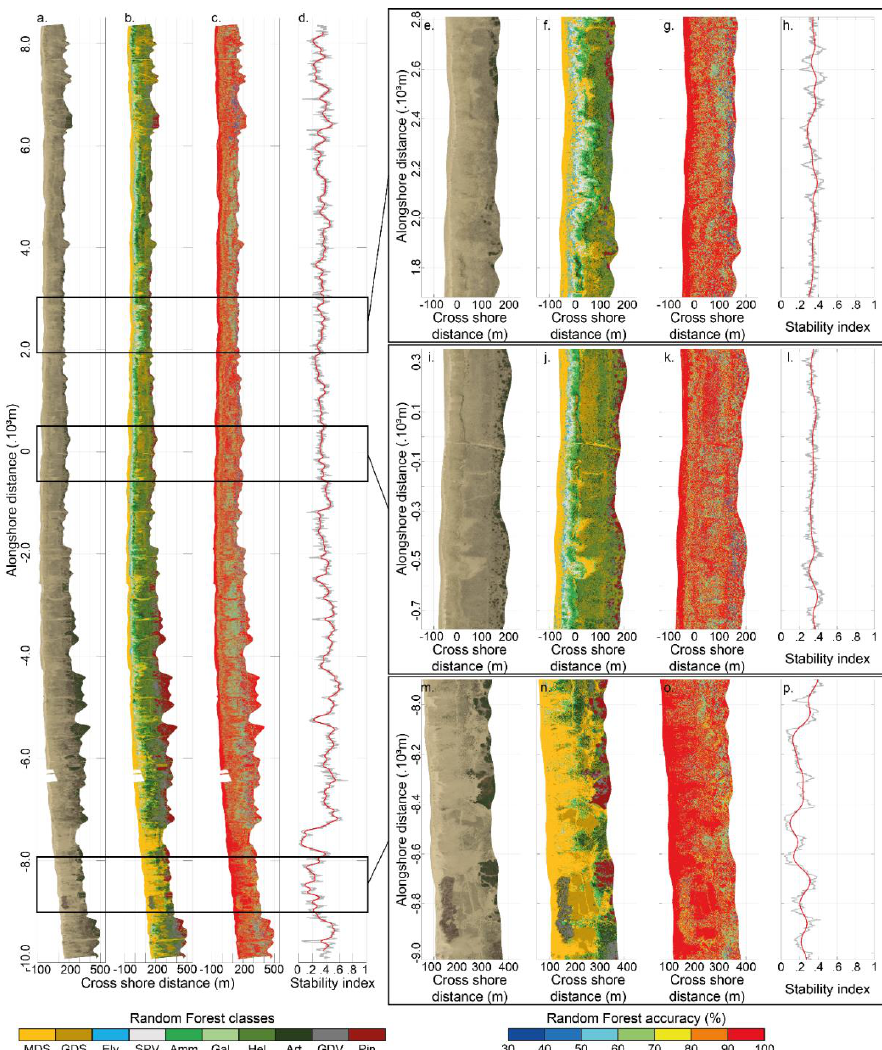
Figure 9. Representation of the 18 km alongshore of the study site with ( a ) the aircraft color orthophoto, ( b ) the result of RF classification, ( c ) the results of RF classification accuracy, and ( d ) the stability index. The right panels represent 1.1 km alongshore zooms of these four parameters for ( e – h ) the northern, ( i – l ) the central, and ( m – p ) the southern